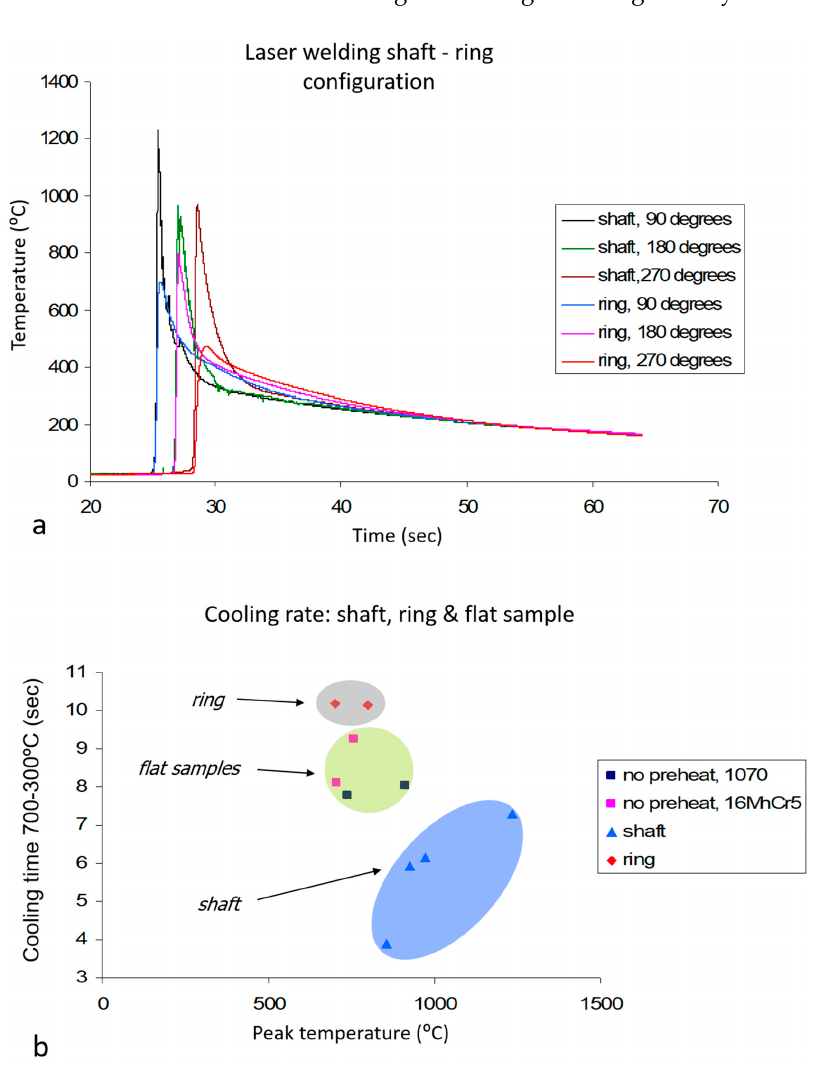
Figure 14. Effect of component geometry on cooling rate, ( a ) thermocouple measurements at the shaft and ring; ( b ) cooling time 700–300 ◦ C for the flat samples, the ring and shaft